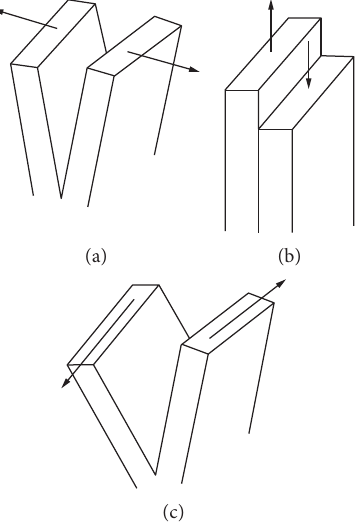
Figure 19: Crack propagation mode [42]: (a) open type, (b) shear type, and (c) tear